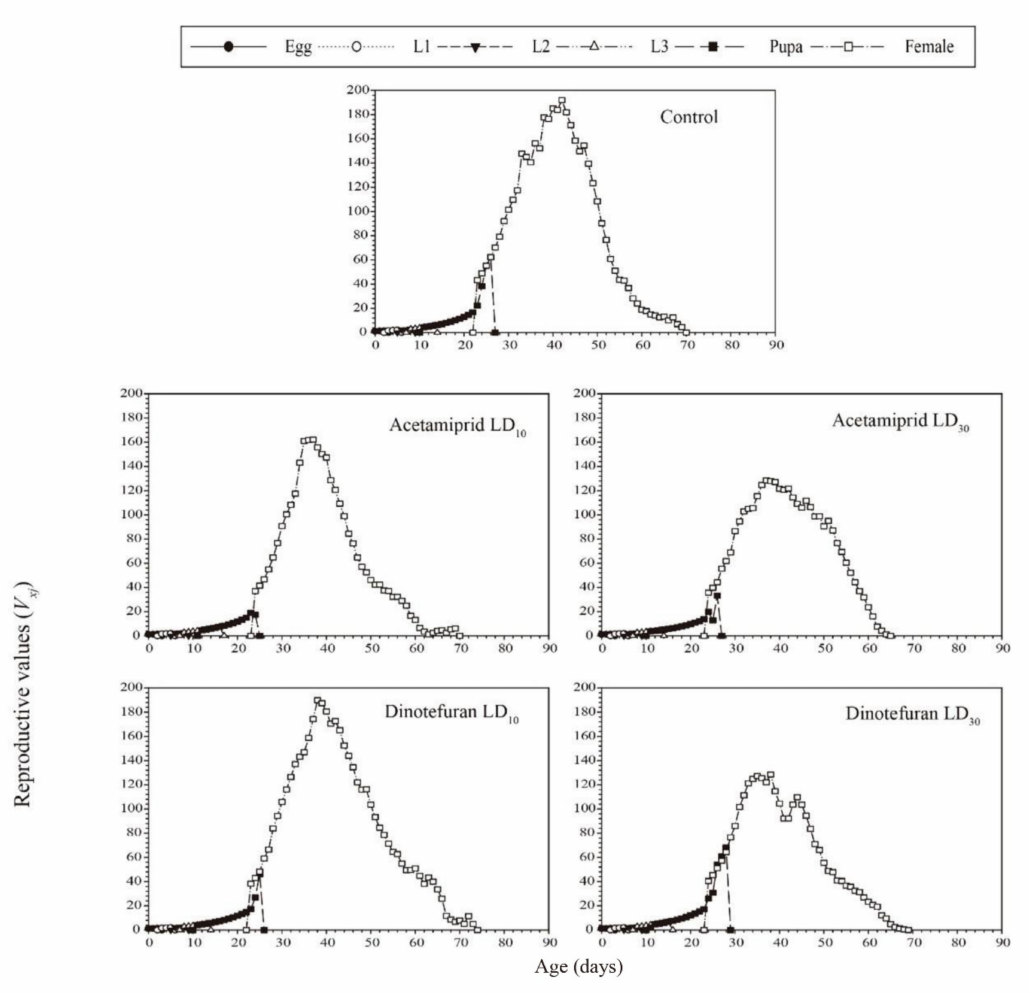
Figure 3. Age-stage-specific reproductive values ( V xj ) values of 2nd instar C. pallens larvae exposed to sublethal acetamiprid and dinotefuran